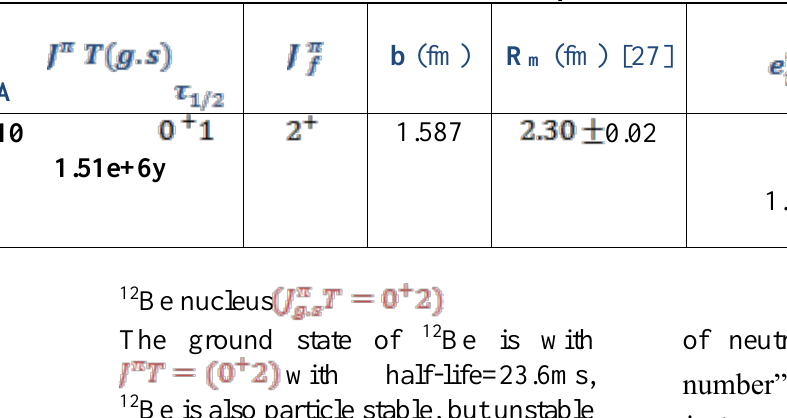
Table 2: The calculated effective charges and B(E2) values of 10 Be compared with the experimental